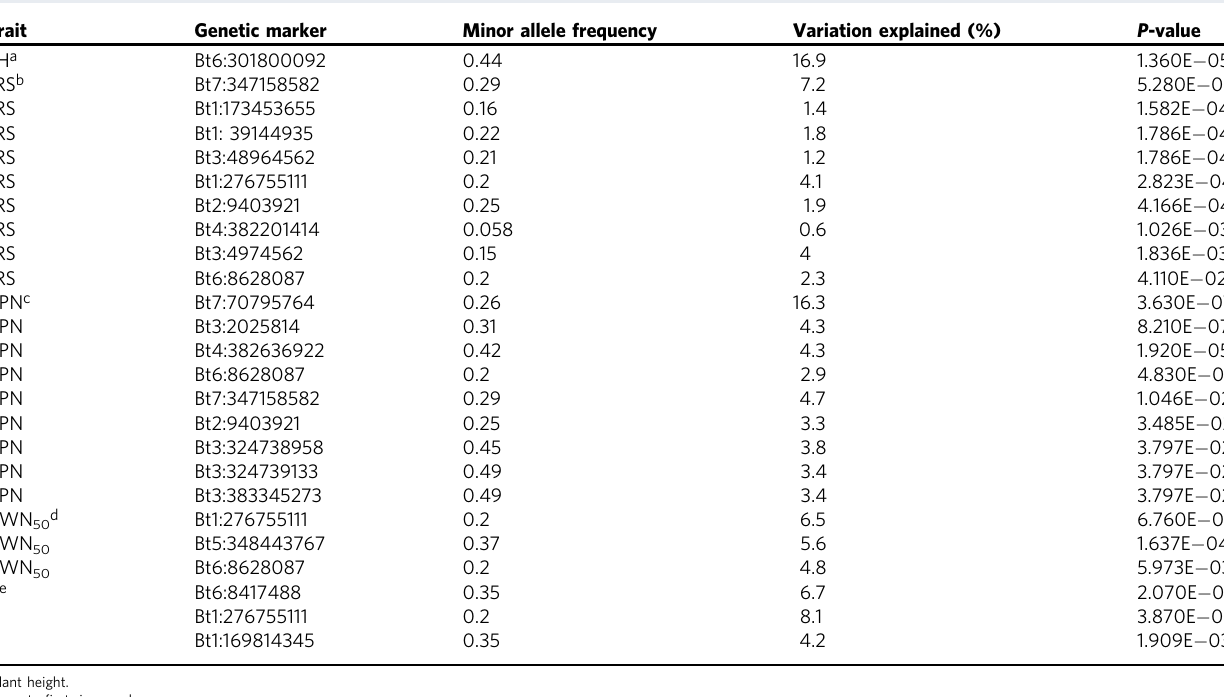
Table 2 Marker-trait associations detected by BLINK for plant height (PH) fi rst ripe seed (FRS), fi rst visible panicle (VPN), or 50% ripe seed (AWN 50 ); the marker the trait appears to be associated with; the minor allele frequency (MAF), the percent of variation explained by the QTL, and the P -value of the SNP after FDR correction for multiple testing. Trait Genetic marker Minor allele frequency Variation explained